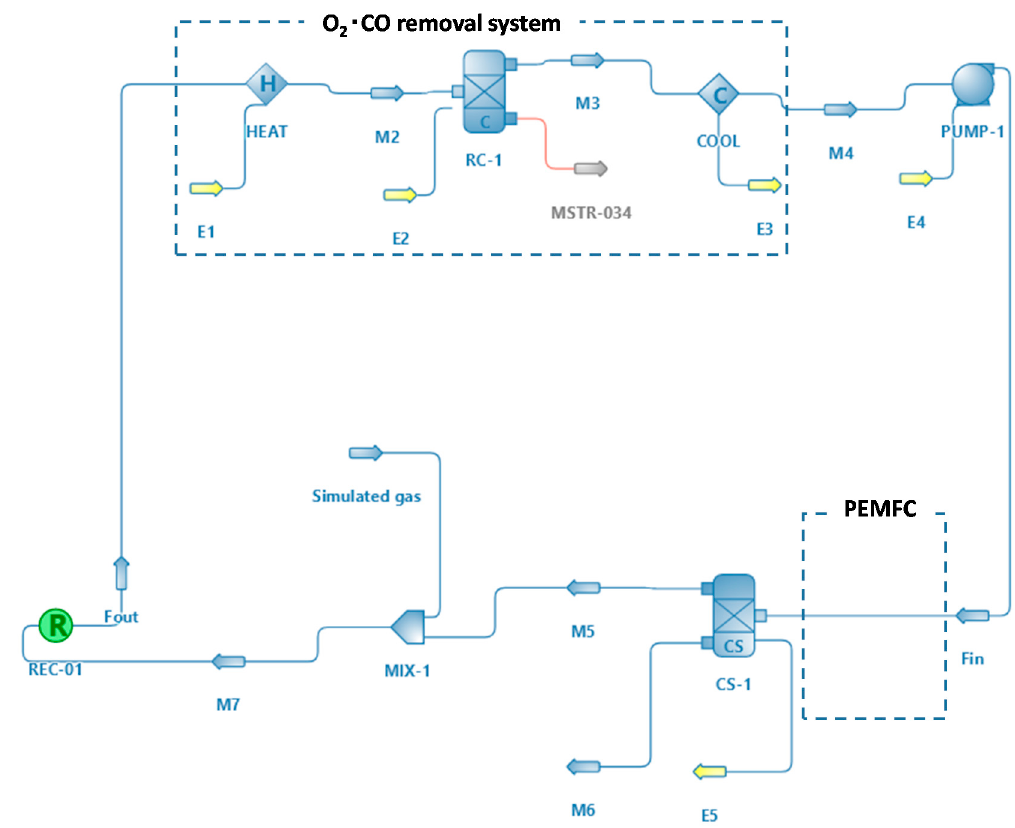
Figure 4. PFD of the biogas fuel cell system.